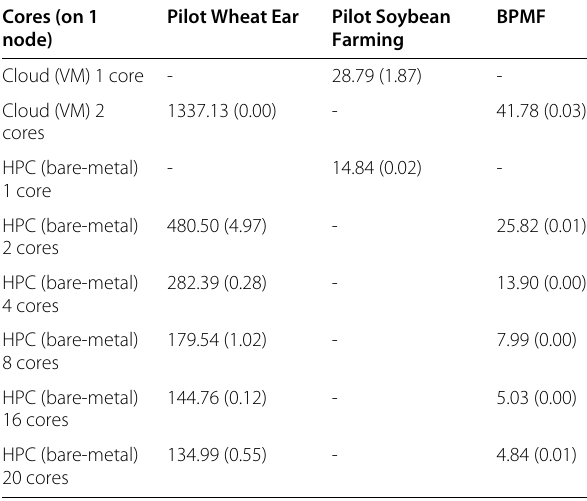
Table 6 Execution time on the Cloud and HPC cluster for 3 use cases on a single node (unit: